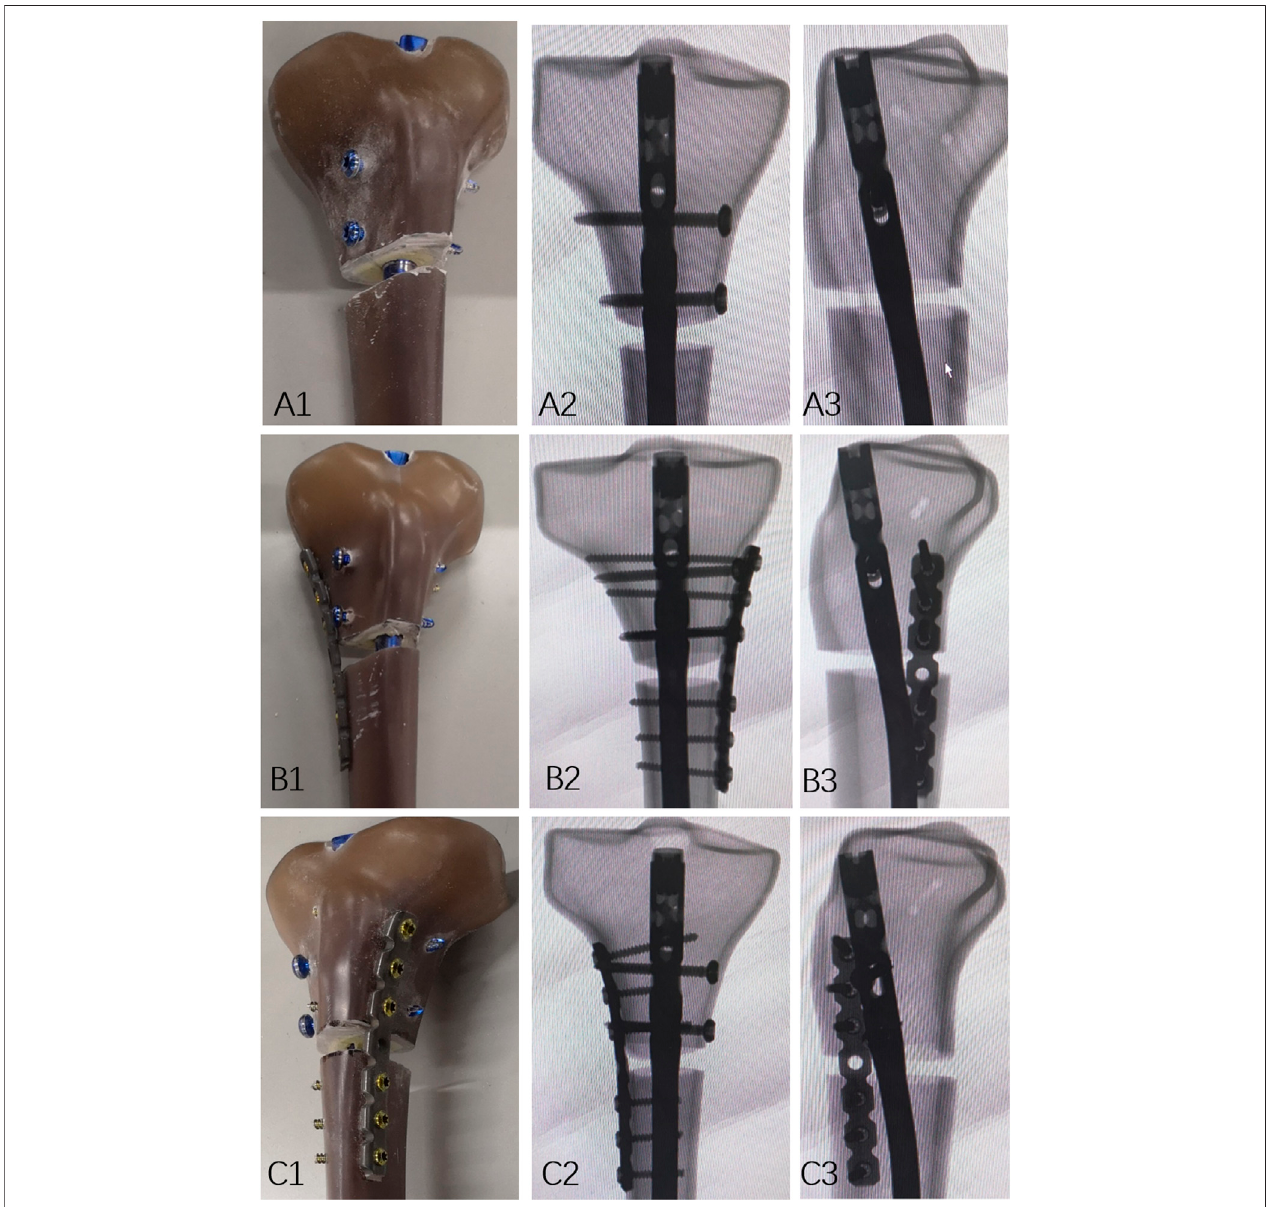
FIGURE1| Models ofthespecimen. (A1) Photographsdemonstrating IMN fi xationspecimens,and (A2,3) Fluoroscopyimages. (B1) Photographsdemonstrating IMN with medial plate fi xation specimens, and (B2,3) fl uoroscopy images. (C1) Photographs demonstrating IMN with lateral plate fi xation specimens, and (C2,3) fl uoroscopy